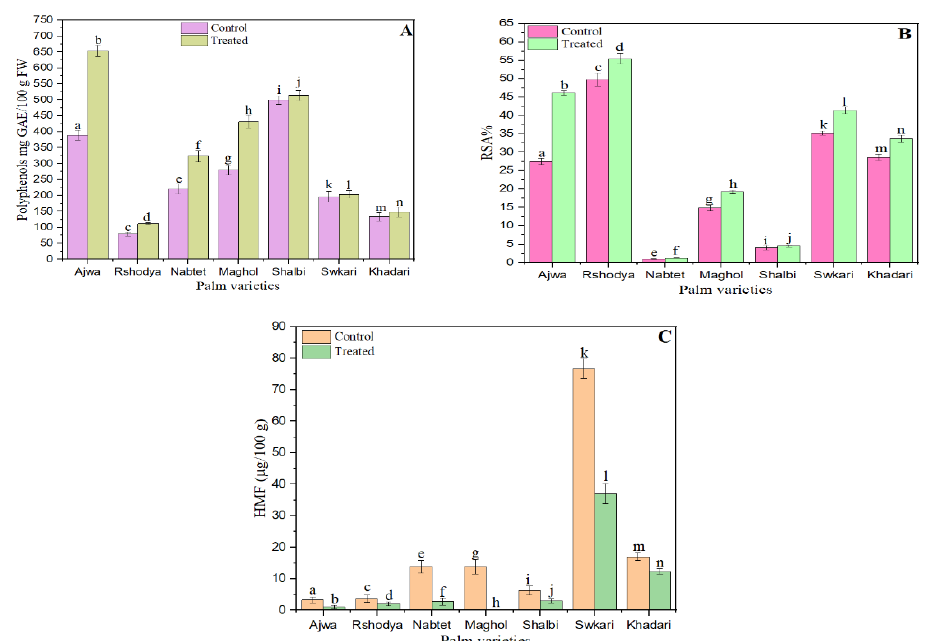
Figure 2. The effect of SDBD plasma on ( A ) total phenol p value = 0.00, ( B ) antioxidant, p value = 0.00, and ( C ) HMF, p value = 0.00 of palm dates, lowercase letters a–n in the same column represent significance analysis; the different letters mean significant difference among various treatments at p < 0.05 level.